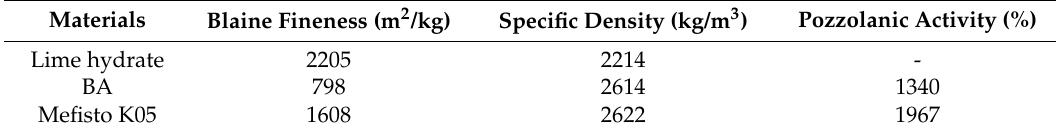
Table 3. Physical parameters and pozzolanic activity of binder constituents.